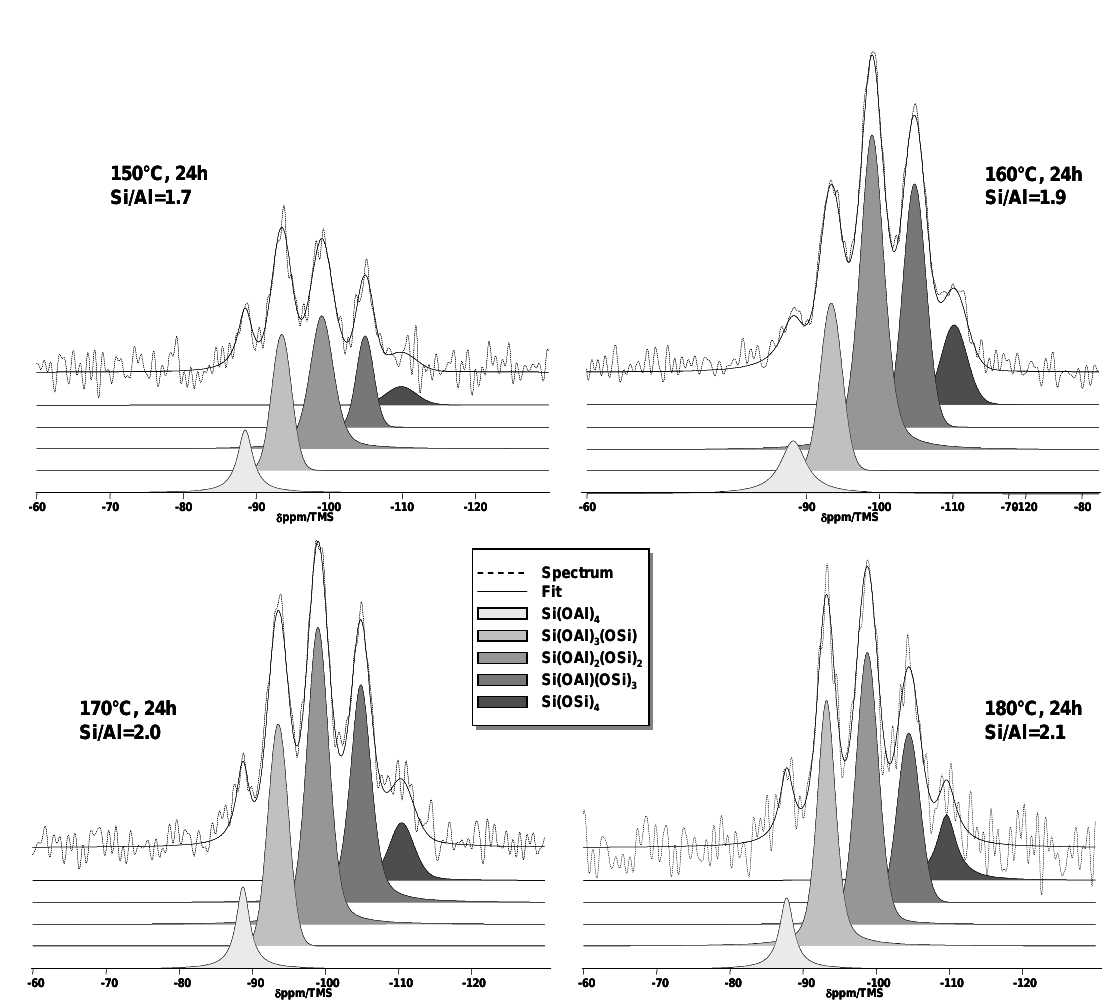
Figure 3. 29 Si MAS + DEC NMR (Magic Angle spinning spectra with heteronuclear DECoupling) spectra of the calcined samples after a hydrothermal treatment of 24 h at 150 °C, 160 °C, 170 °C and 180 °C.